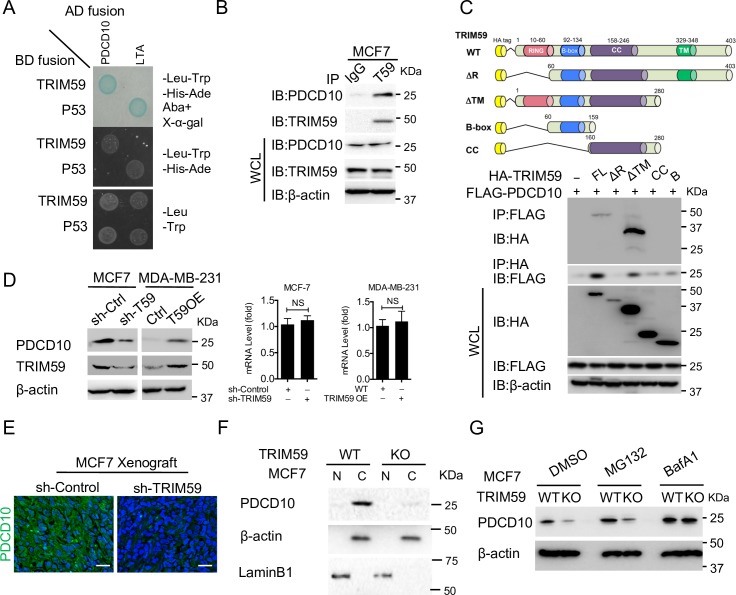
TRIM59 interacts with PDCD10 and blocks the autophagic degradation of PDCD10.(A) Yeast two-hybrid screening to confirm the interaction between TRIM59-BD and PDCD10-AD. Transformed and mated cells were grown on–Leu–Trp medium (bottom). Interaction of TRIM59 with PDCD10 was verified on high-stringency plates (–Leu–Trp–His–Ade) and with a β-galactosidase filter assay and Aureobasidin A (AbA) (top). Interaction of p53 and SV40 large T-antigen (LTA) was used as positive control. (B) Co-IP and IB analysis of extracts of MCF7 cells with the indicated antibodies. IP with IgG was added as a negative control. (C) Co-IP and IB analysis of extracts of HEK293T cells transfected with FLAG-PDCD10 along with HA-tagged TRIM59 variants (full-length WT or deletions [ΔR, ΔTM, B, and CC] as shown on the top cartoon). (D) IB and qPCR analysis of PDCD10 protein expression (left) and mRNA levels (right) in shControl and shTRIM59 MCF7 cells (D, lane 1 versus 2) or in control and TRIM59 OE MDA-MB-231 cells (D, lane 3 versus 4). Data are presented as means ± SD. NS versus controls. The underlying data can be found in S1 Data. (E) Representative immunofluorescent staining of PDCD10 (green) in sections from xenograft of shControl or shTRIM59 MCF7 cells. DAPI, DNA-intercalating dye, indicates the nucleus (blue). Scale bars: 100 μm. n = 4. (F) IB analysis of PDCD10 expression in MCF7 WT or TRIM59 KO cell fractions. β-actin and LaminB1 were used as markers for the cytosolic and nuclear fractions, respectively. (G) IB analysis of PDCD10 expression in WT or TRIM59 KO MCF7 cells treated with DMSO or 10 μM MG132 (proteasome inhibitor) or 200 nM BafA1 (autophagy inhibitor). See S4C Fig for similar experiments using TRIM59 KD cells. ΔR, TRIM59 without RING domain; ΔTM, TRIM59 without the predicted transmembrane domain; AbA, Aureobasidin A; AD, transcription activation domain;–Ade, adenine dropout; B, B-box-type zinc finger domain; BafA1, bafilomycin A1; BD, DNA-binding domain; C, cytosolic fraction; CC, coiled-coil domain; co-IP, co-immunoprecipitation; HA, hemagglutinin;–His, histidine dropout; IB, immunoblot; IgG, immunoglobulin G; IP, immunoprecipitation; KD, knockdown; KO, knockout;–Leu, Leucine dropout; LTA, large T-antigen; N, nuclear fraction; NS, not significant; OE, overexpressing; PDCD10, programmed cell death protein 10; p53, tumor protein 53; qPCR, quantitative polymerase chain reaction; SV40, polyomavirus simian virus 40; TM, transmembrane domain; TRIM59, tripartite motif 59;–Trp, tryptophan dropout; WT, wild-type.